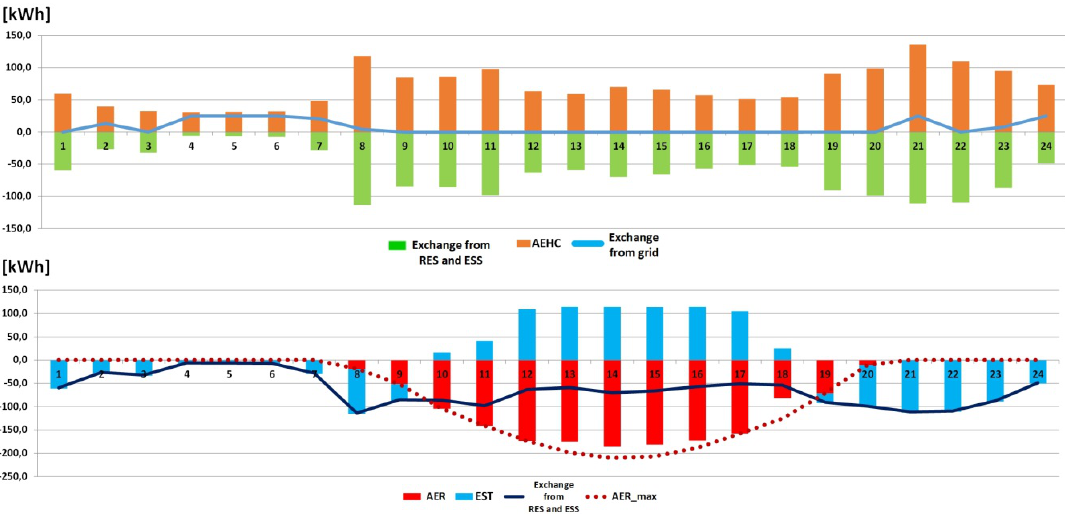
Figure 15. Energy management during the simulation day under the type-A self-consumption scheme, with an ESS configuration.